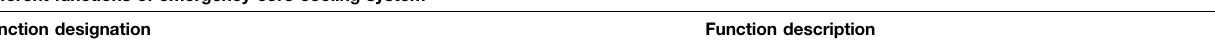
TABLE 4 | Chart description of different functions in the emergency core cooling system (AEOI, 2003). Different functions of emergency core cooling system Function